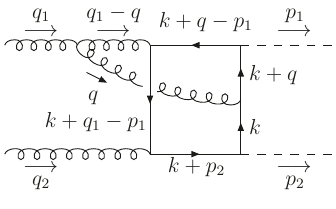
Figure 5 . Explicit de(cid:12)nitions of the virtual momenta in box